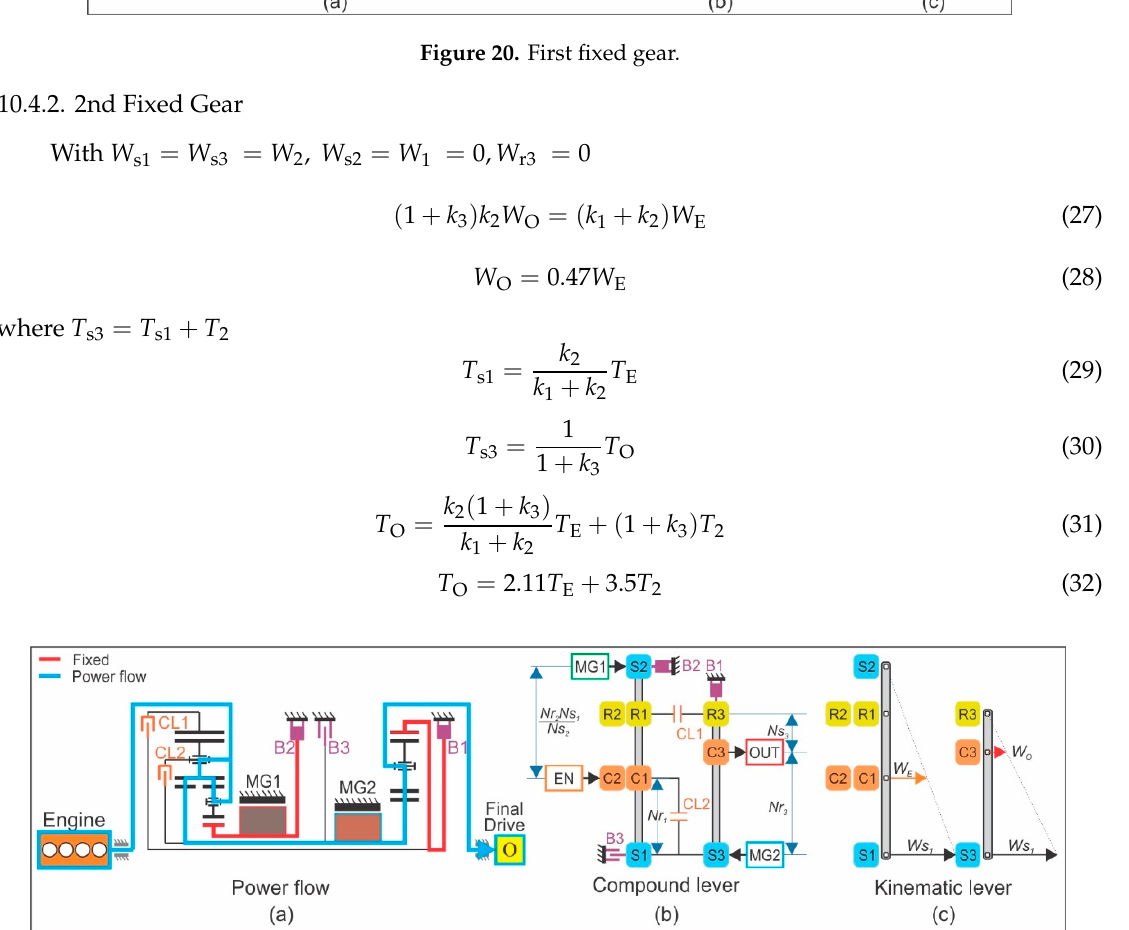
Figure 21. Second fixed gear.